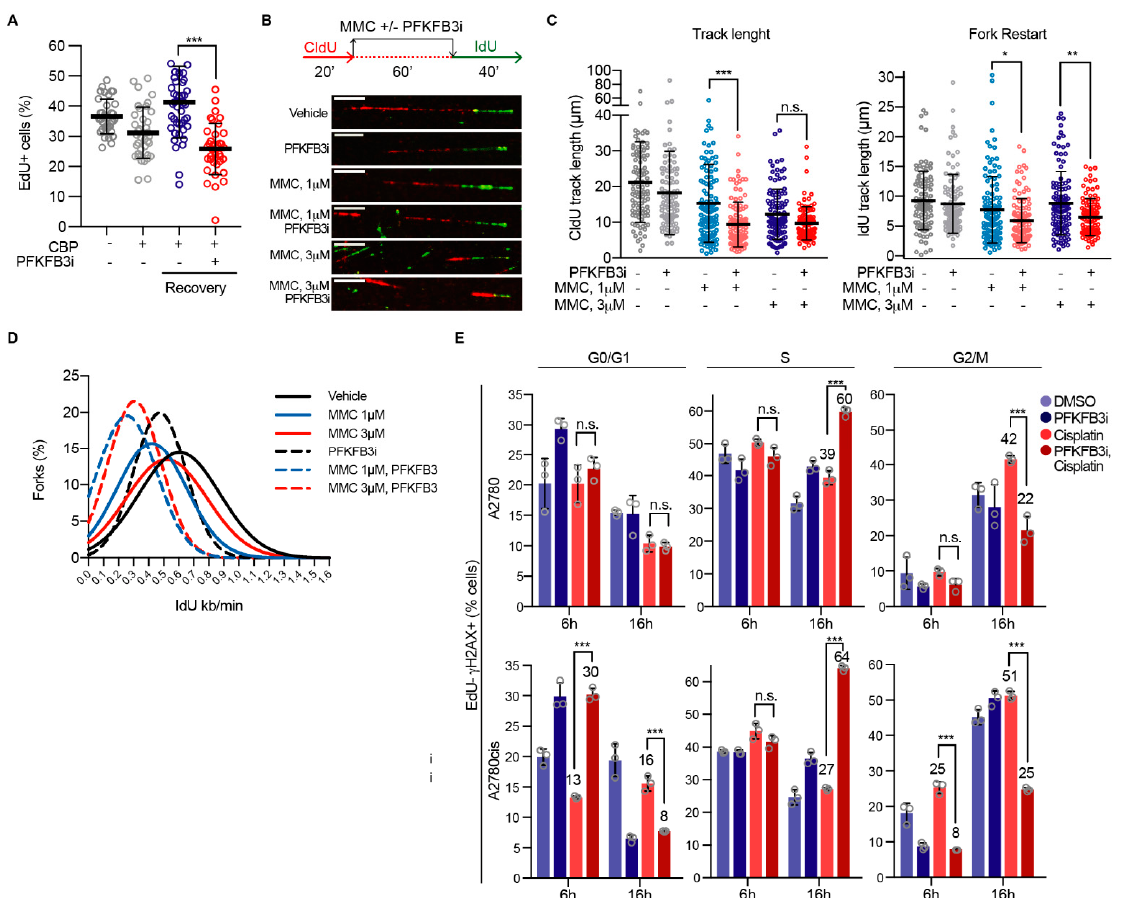
Figure 5. PFKFB3 inhibition impairs replication fork restart eliciting a FA-like phenotype in replicating cells. ( A ) Quantification of percentage of EdU positive A2780 cells. Cells were treated with carboplatin (CBP, 50 µM) for 20 h, followed by co-treatment with PFKFB3 inhibition (PFKFB3i, 10 µM) for 4 h. Cells were then released into normal media for 24 h, and pulse-labelled with 10 µM EdU for 30 min prior fixation. Cells were immunostained, subjected to confocal imaging, and EdU intensities were quantified using CellProfiler. EdU-positive threshold was established by the EdU intensity levels from the untreated sample. Data shown as means ± S.D., where each data point represents percentage of cells per picture, n = 2. *** p < 0.001; Mann–Whitney test. ( B ) A2780 cells were analyzed for replication fork restart. Shown is a schematic representation of the experimental setup and representative images of replication tracks for each condition. Cells were labeled with DNA analogs, CldU for 20 min followed by 60 min treatment with indicated concentrations of Mitomycin C (MMC) with or without PFKFB3 inhibition (B3i, 10 µM) and then IdU for 40 min. DNA fibers were prepared and visualized by immunofluorescence detection of CldU and IdU. Scale bar, 10 µm. ( C ) Fiber track length measurement from ( B ). Left panel shows mean CldU track lengths, right panel displays fork restart as mean IdU track lengths. One data point represents track length of a single fork, data are displayed as scatter dot plots with means ± S.D. of n > 100 forks per condition, representative experiment of n = 2, * p < 0.05, ** p < 0.01, *** p < 0.001; ordinary one-way ANOVA analysis, Tukey’s test for multiple comparisons. ( D ) Distribution of fork speed upon replication fork restart in cells in ( B ), n > 100 restarted forks per condition, representative experiment of n = 2 . ( E ) Cell cycle analysis of EdU- γ H2AX double positive A2780 and A2780cis cells. After cell cycle synchronization with aphidicolin (6 µM) for 24 h, cells were pulsed with EdU for 30 min and then released into cisplatin (10 µM) with or without PFKFB3i (5 µM) or left untreated for either 6 h or 16 h prior fixation. Data displayed asmeans ± SD of n > 20,000 events, representative experiment of n = 2, *** p < 0.001; ordinary one-way ANOVA analysis, Tukey’s test for multiple